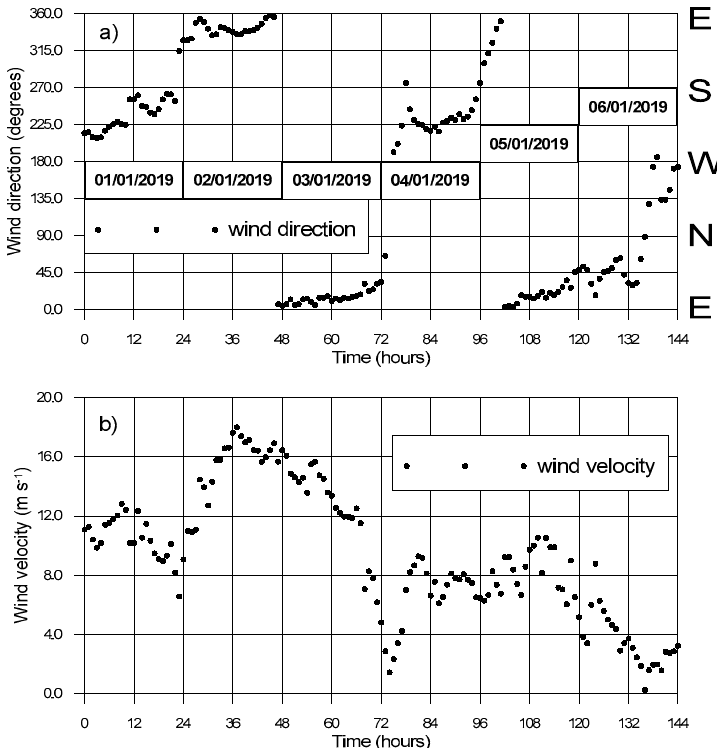
Figure 18. Wind parameters observed at Nowa Pasł˛eka (1 January–6 January 2019), ( a ) direction, ( b ) velocity.